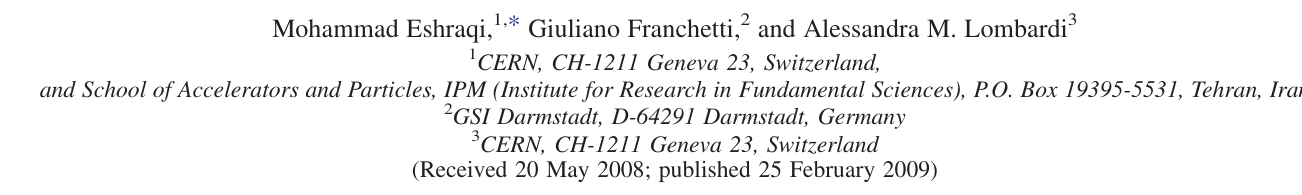
FIG. 1. Layout of LINAC4, not to scale